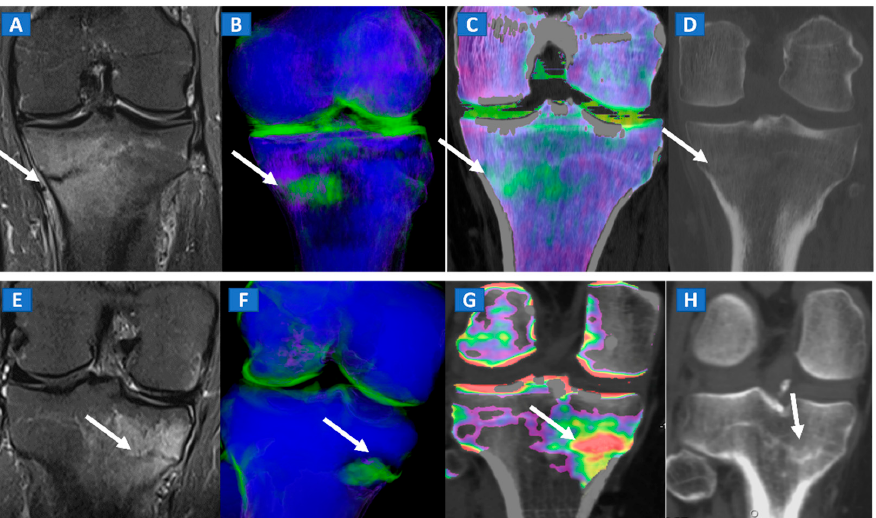
Figure 7. A 42-year-old male long - distance runner with a bilateral tibial stress fracture. On the coronal STIR MRI images ( A , E ), a hypointense serpiginous subchondral line (arrows), surrounded by subtle BME involving the proximal tibia on the medial side, is depicted. On the DECT 3D maps ( B , F ) some BME is apparent around the fractures (arrows). On the corresponding DECT coronal 2D images ( C , G ), the presence of BME is confirmed (arrows), with a periphery to center gradient. The standard coronal reconstructed CT images ( D , H ) confirm the fracture lines (arrows). Note the absence of reactive sclerosis in the left knee ( D ) and the presence of sclerosis in the right one ( H